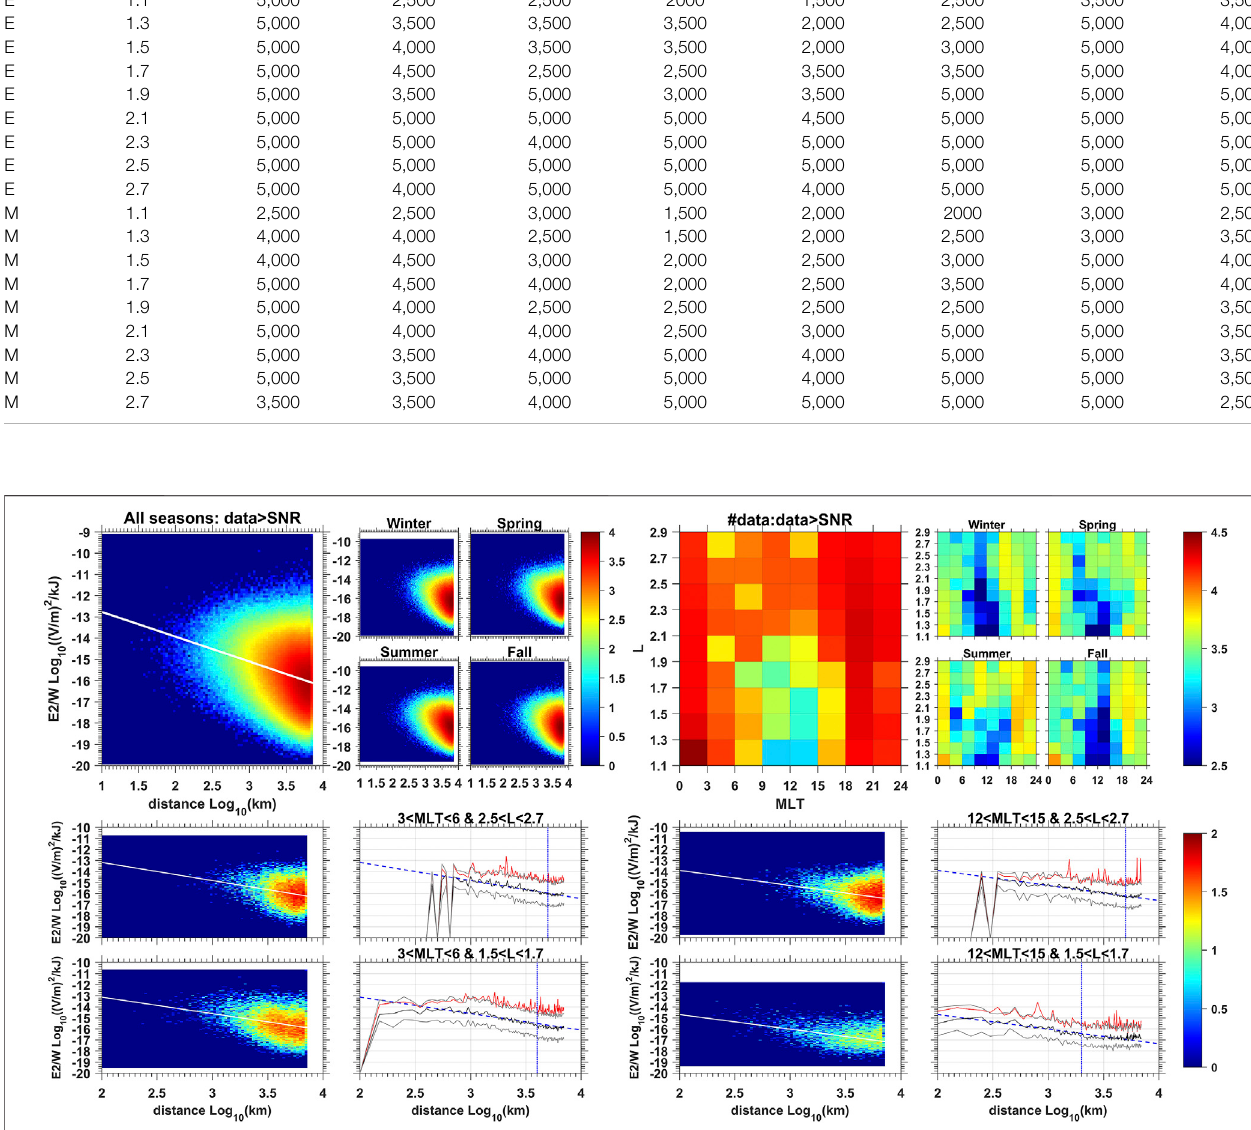
Frontiers in Physics |